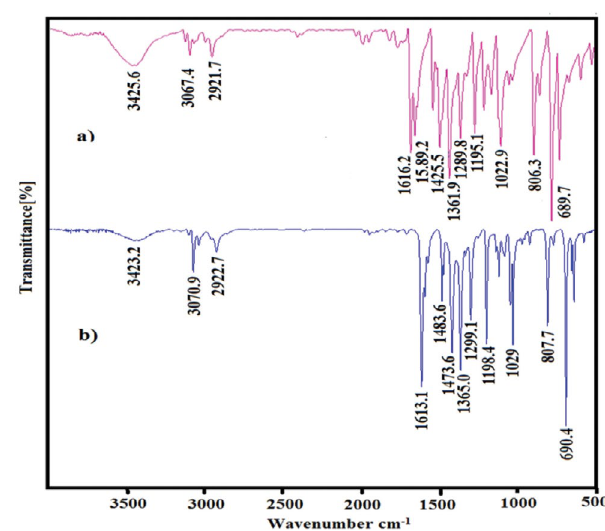
Fig. 2. The IR spectra of complex (1) at (a) bulk form and (b)